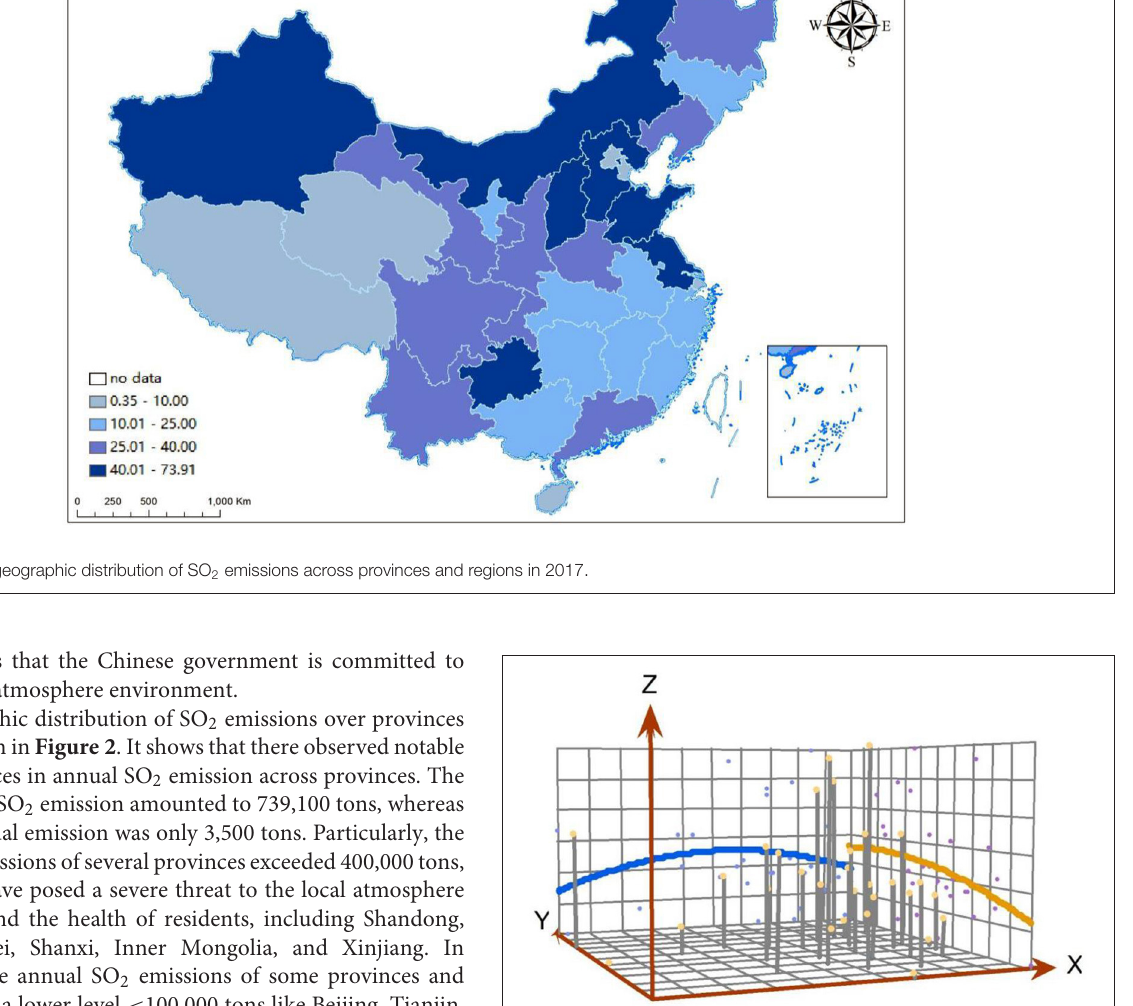
FIGURE 3 | The perspective view of the geographic distribution of SO 2 emissions in